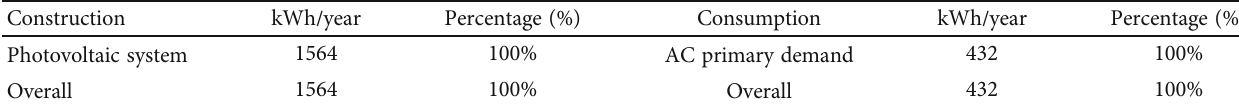
Figure 3: Photovoltaic backup system. Table 1: Yearly power production and consumption on a stand-alone system.